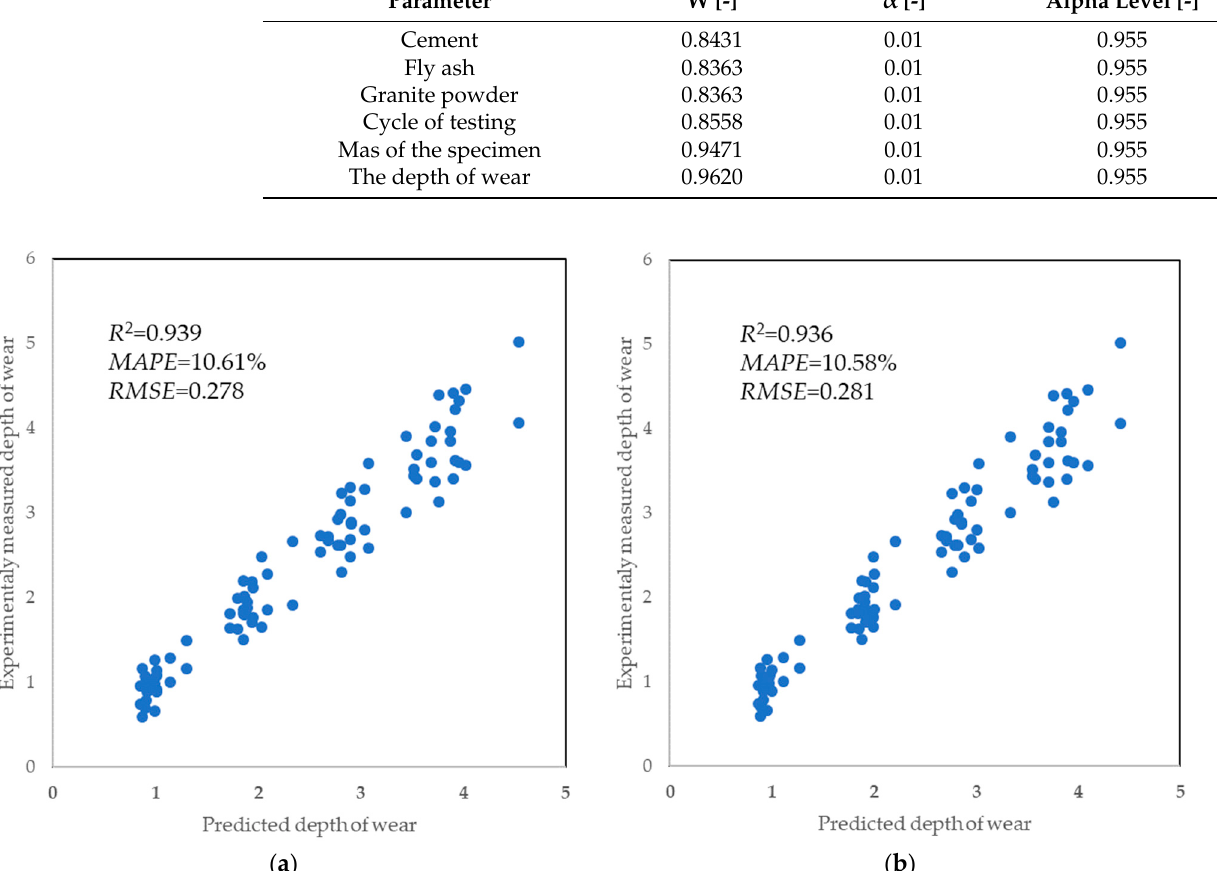
Figure 9. Results of the prediction for the ( a ) ANN and ( b ) random forest.